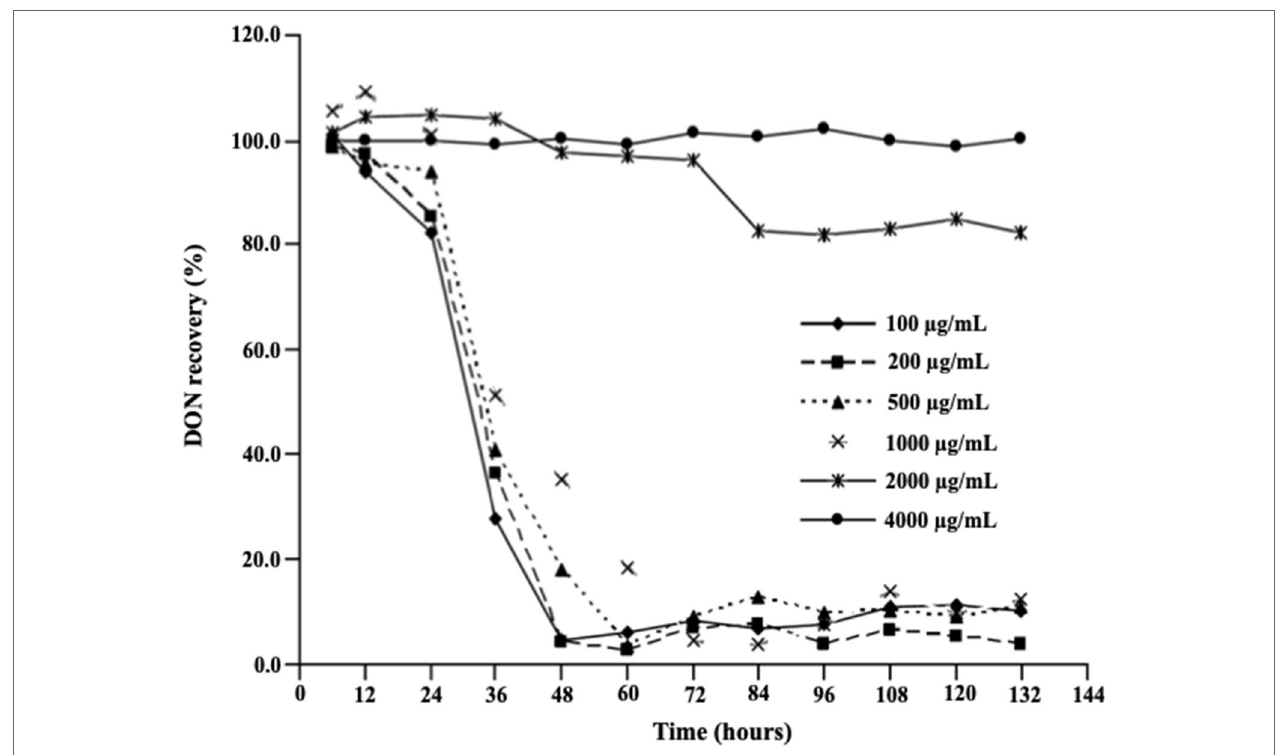
FIGURE 2 | Deoxynivalenol biotransformation capacity of D. mutans 17-2-E-8. The ability of D. mutans 17-2-E-8 to transform DON (in growth media) is only saturated at extremely high concentrations of the toxin. Concentrations that ranged from 10 to 1,000 µg/ml had no negative effect on the bacterium’s ability to oxidize/epimerize DON (He et al., 2016) in cornmeal broth cultures at 28°C and 200 rpm. The protected least significant difference [PLSD (0.05) ] of the test was